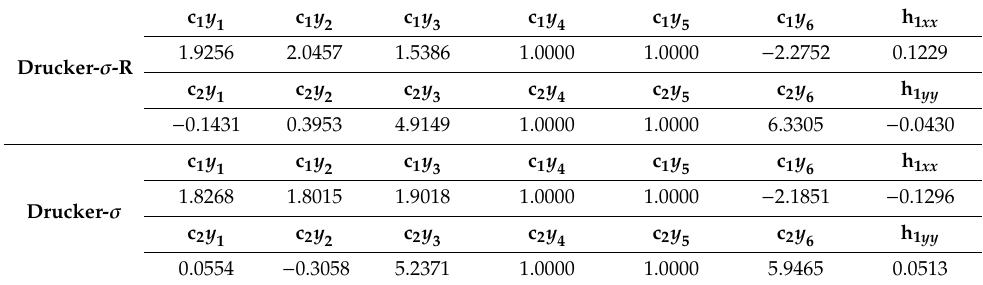
Table 6. Parameters of the extended Drucker yield functions for AA 2090-T3 sheet.